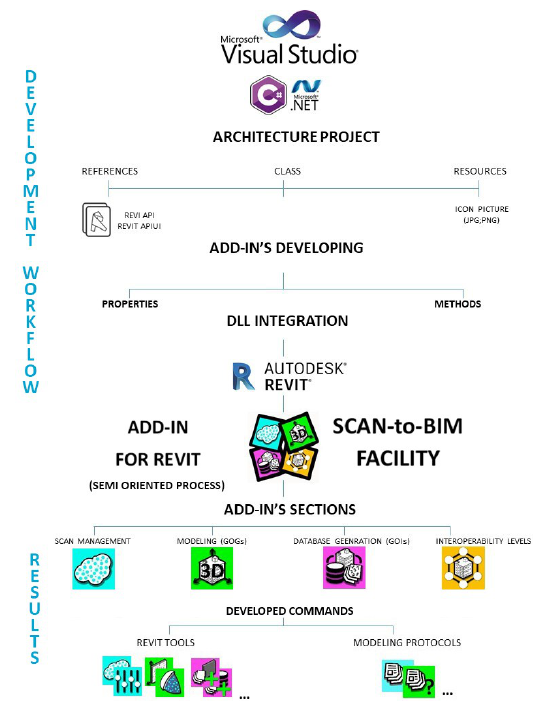
Figure 6. The development process of Scan-to-BIM Facility tool. The add-in allows the integration of the proposed method in BIM application, supporting the user with a guided